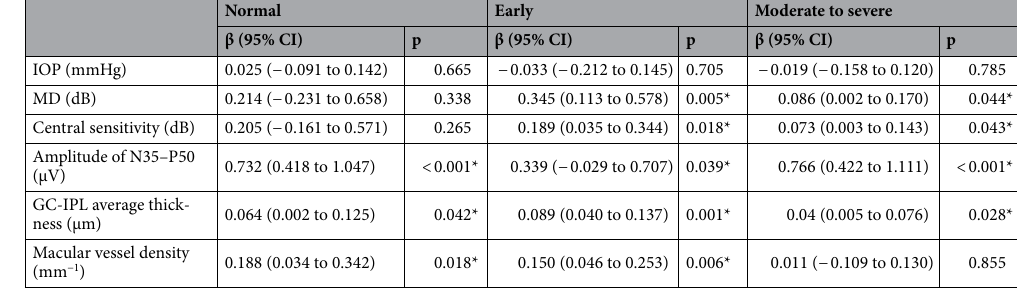
Table 2. Age-adjusted correlation analysis between the amplitude of P50–N95 and other parameters for glaucoma evaluation in the normal, early, and moderate to severe NTG groups. CI confidence interval, IOP